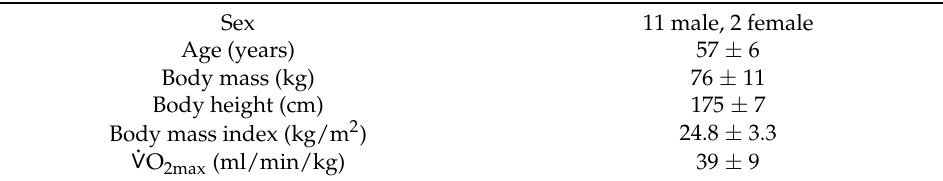
Table 1. Anthropometric data of study participants (N =